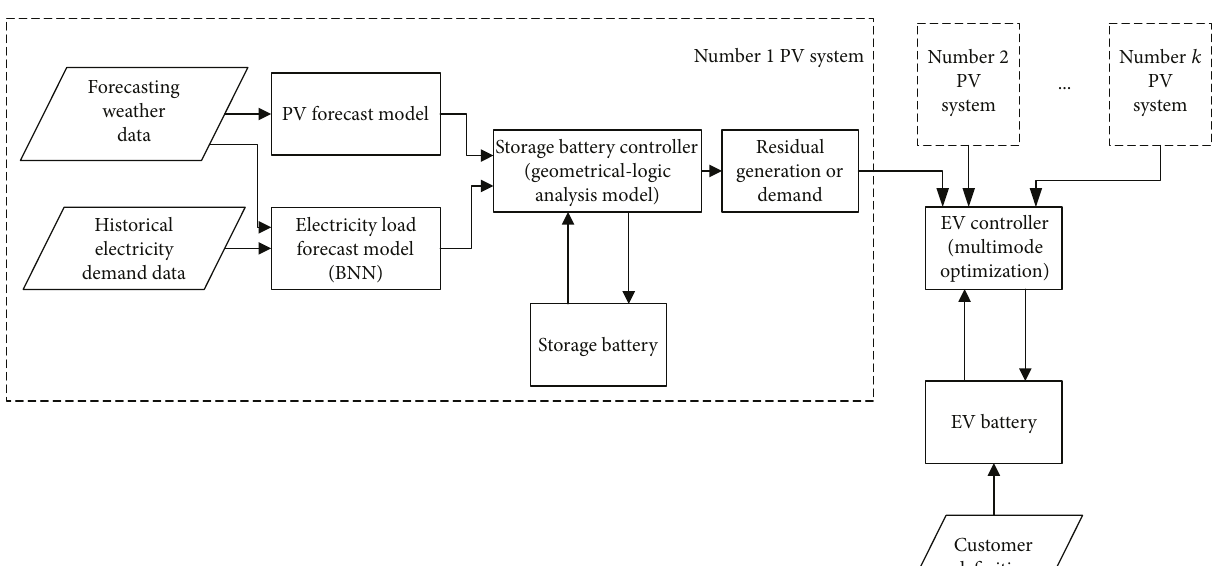
Figure 2: Control schematic of the distributed PV systems with EV multiple-mode